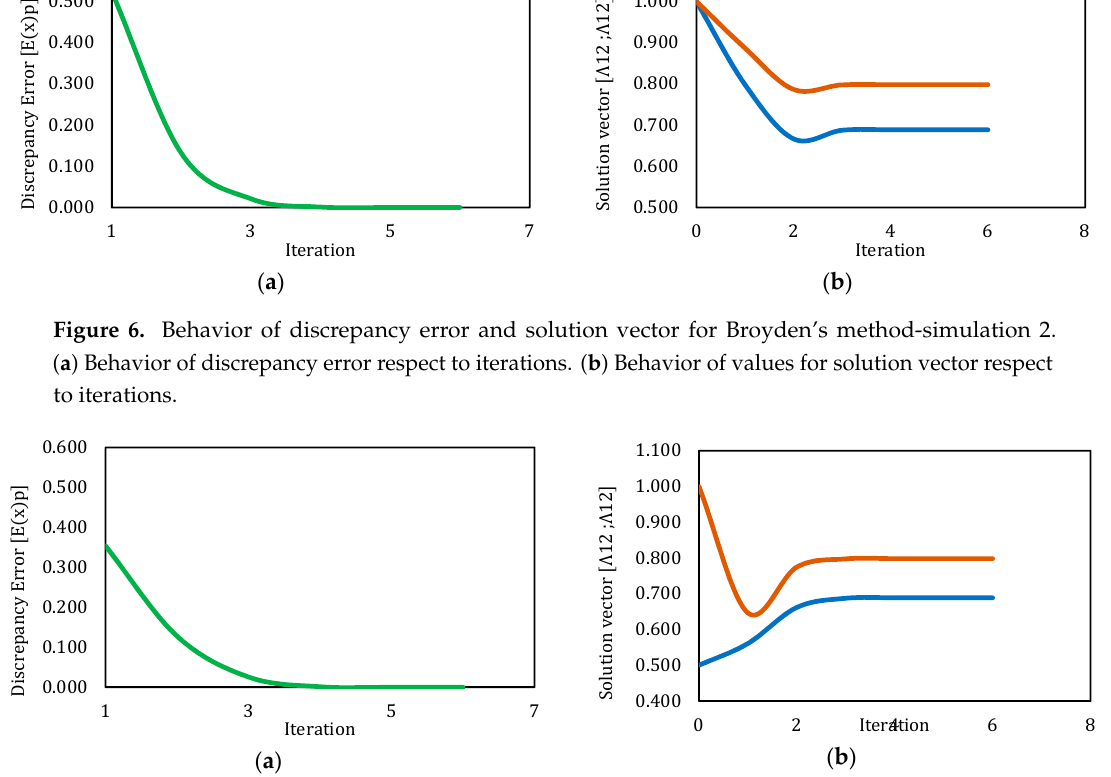
Figure 7. Behavior of discrepancy error and solution vector for Broyden’s method-simulation 3. ( a ) Behavior of discrepancy error respect to iterations. ( b ) Behavior of values for solution vector respect to iterations.